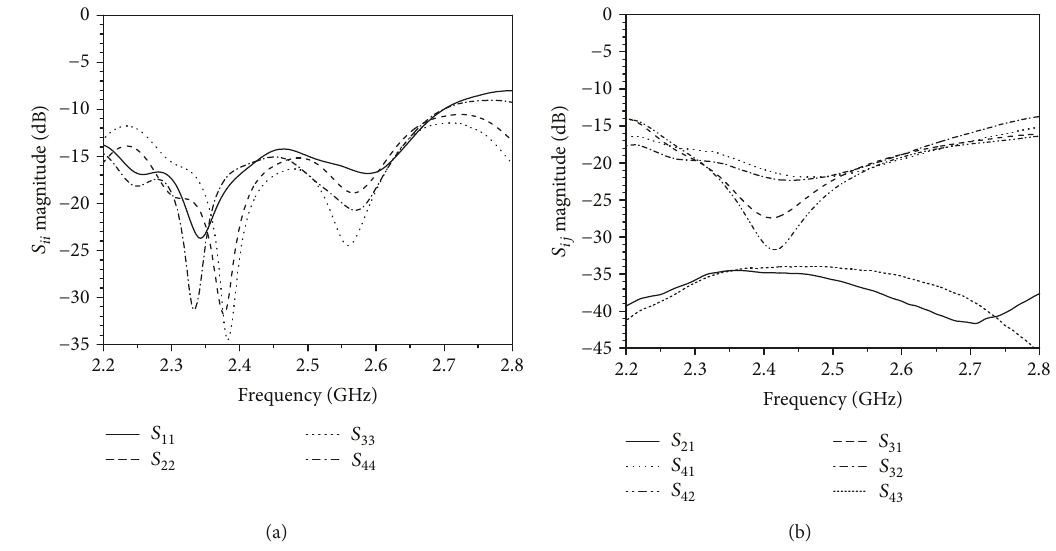
Figure 6: Measured magnitude of (a) the return losses and (b) the isolation coe ffi cients of the 4 × 4